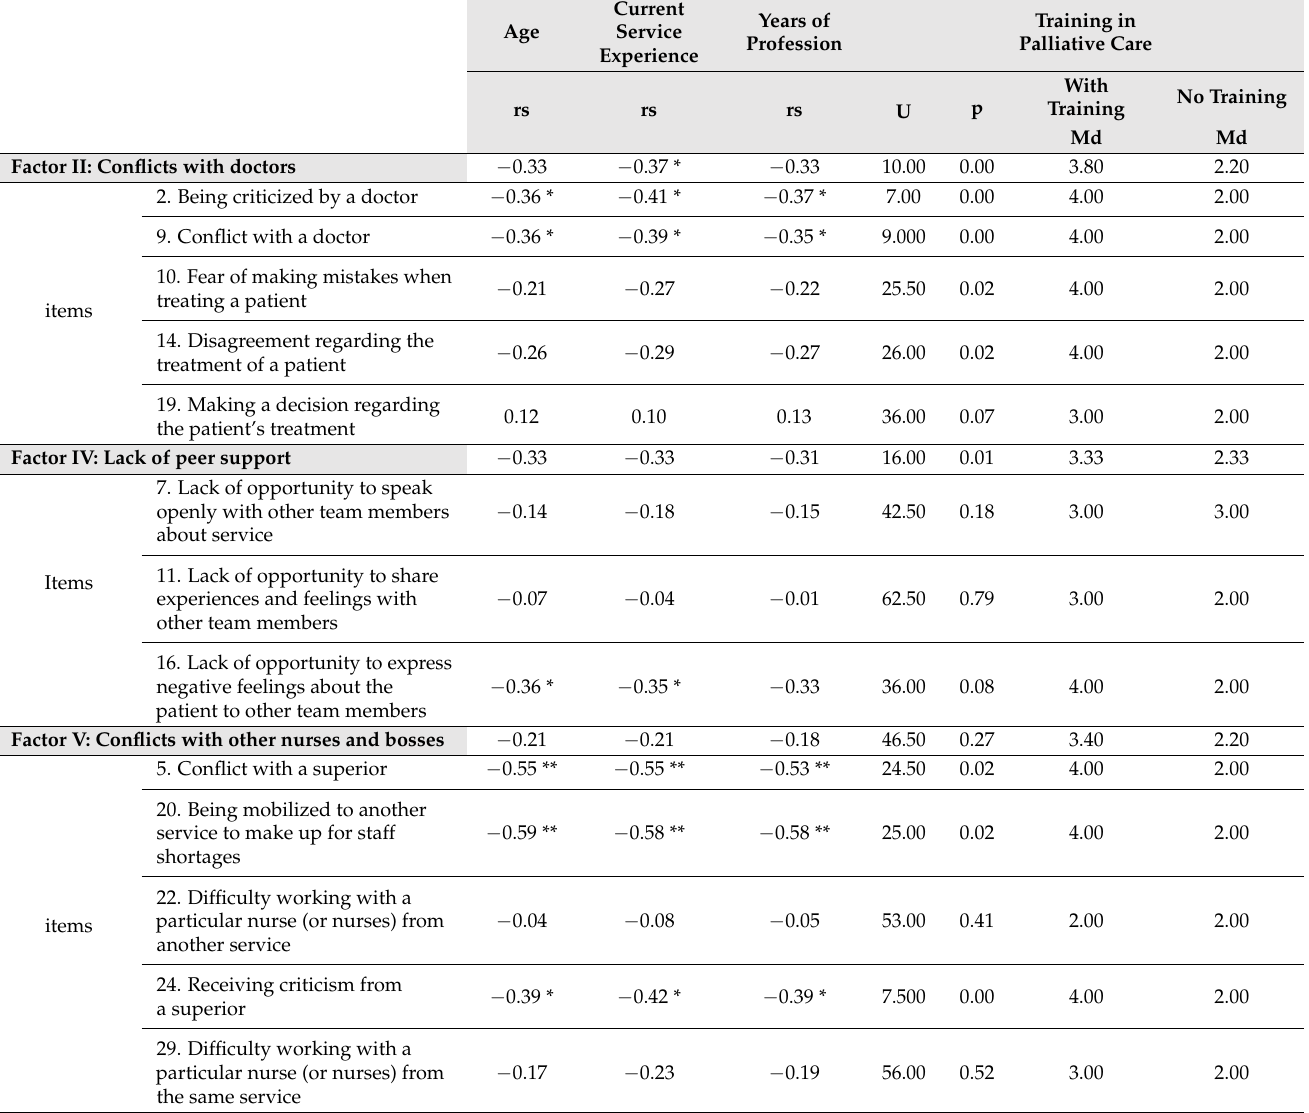
Table 3. Statistical analysis between interpersonal domain and demographic and professional